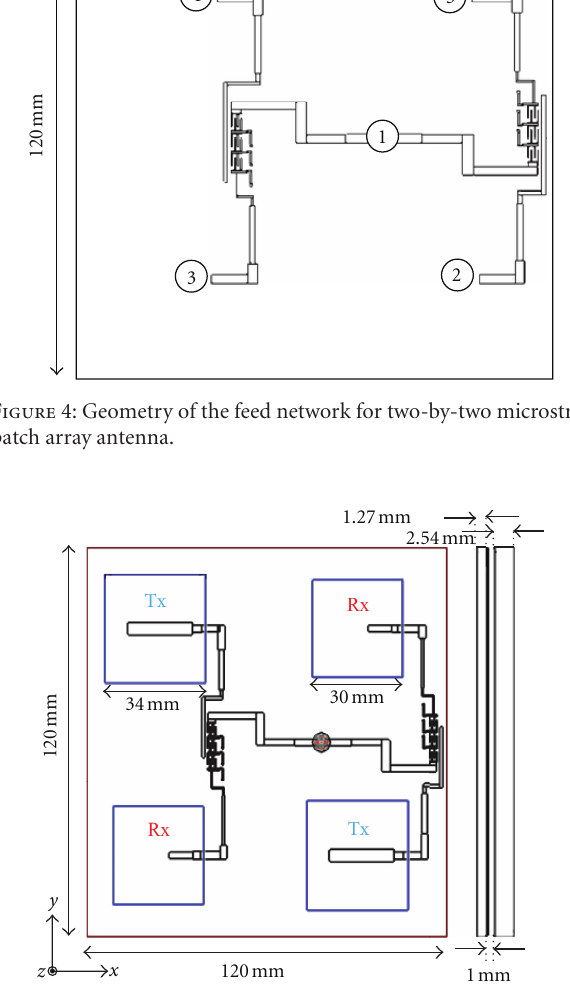
Figure 5: Geometry of the proposed switchable feed network for two-by-two microstrip patch array